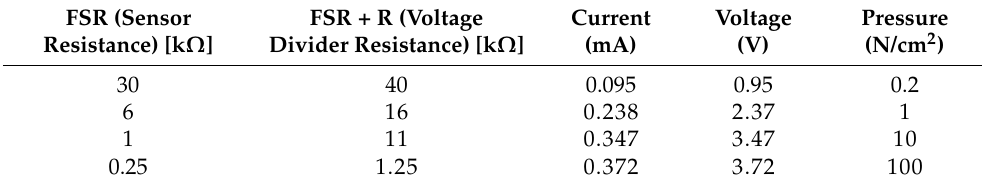
table can be generated, including pressure. Table 2 shows how resistance is translated to pressure units. For this table, the resistance of the sensor in units of kilo ohms (k Ω ), the voltage of the voltage divider in volts (V), and the pressure measured in Newtons per square centimeter (N/cm 2 ). Table 2. Equivalence between resistance, voltage, and pressure. Table 2. Equivalence between resistance, voltage, and